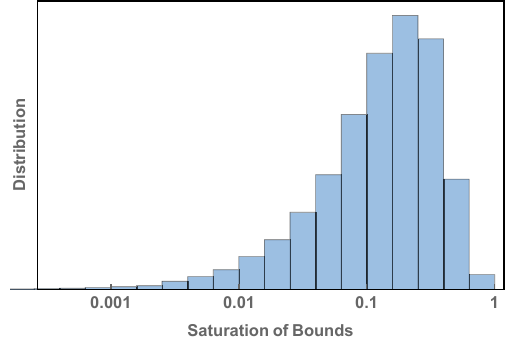
2 normalized to their respective δ ij V ij | − | | |